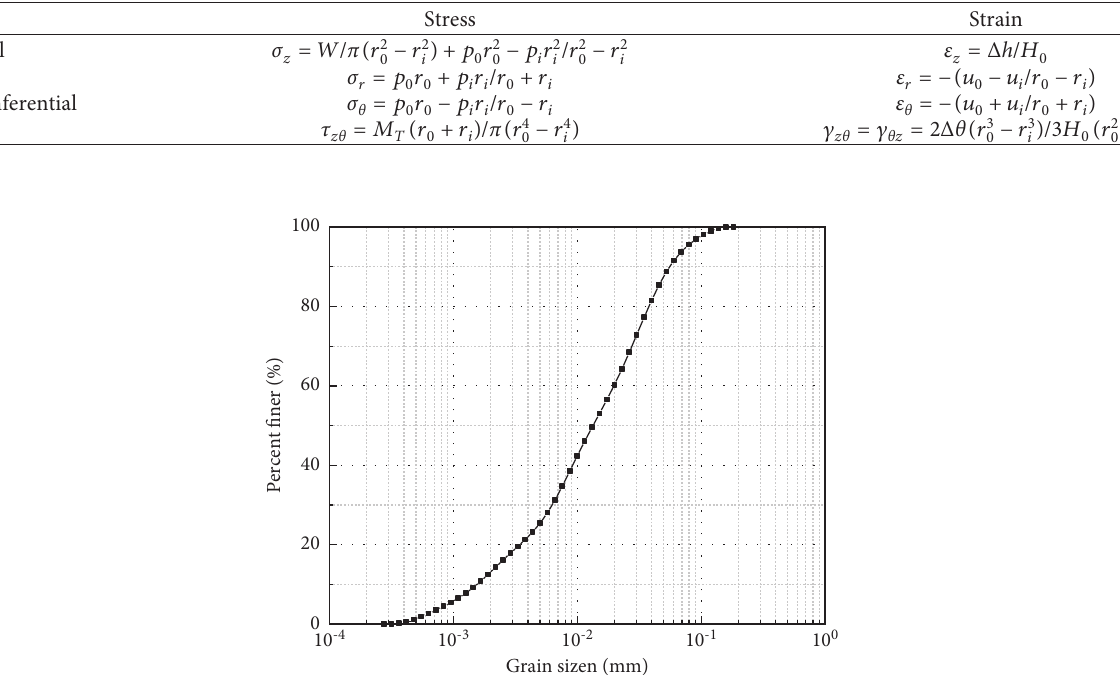
Figure 2: Cumulative curve of grain size grading of the frozen